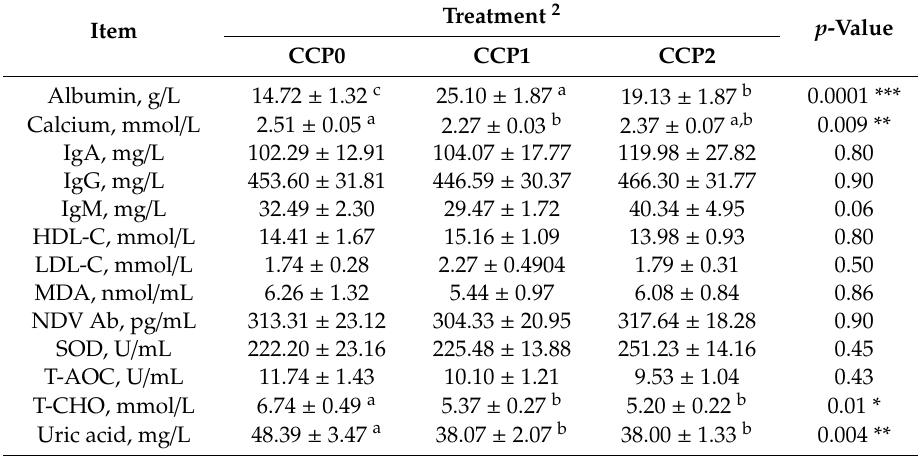
Table 6. E ff ect of dietary Camellia oleifera cake polysaccharides on the blood profile of yellow broilers ( ± SEM 1 ) at 50 days.